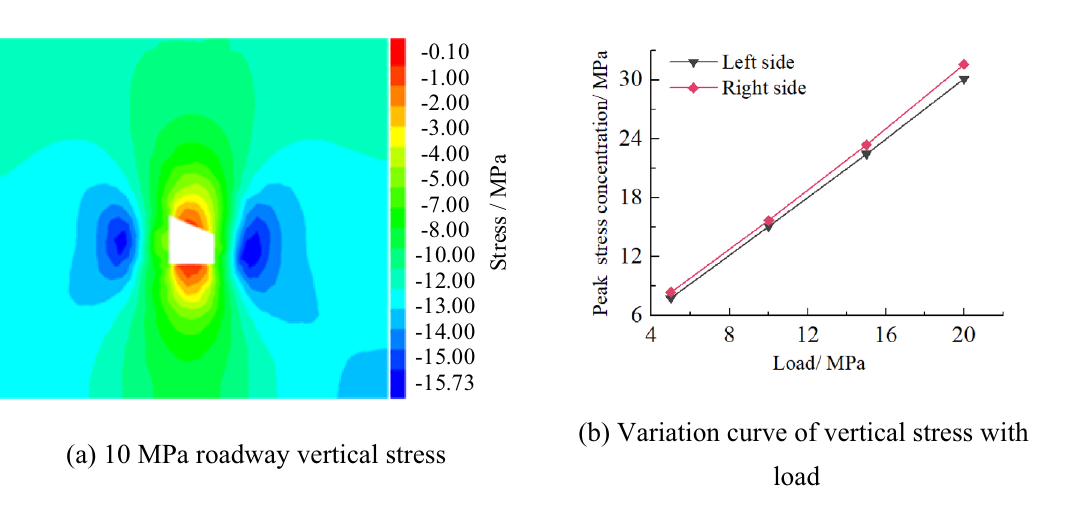
Figure 17. Vertical stress distribution law of